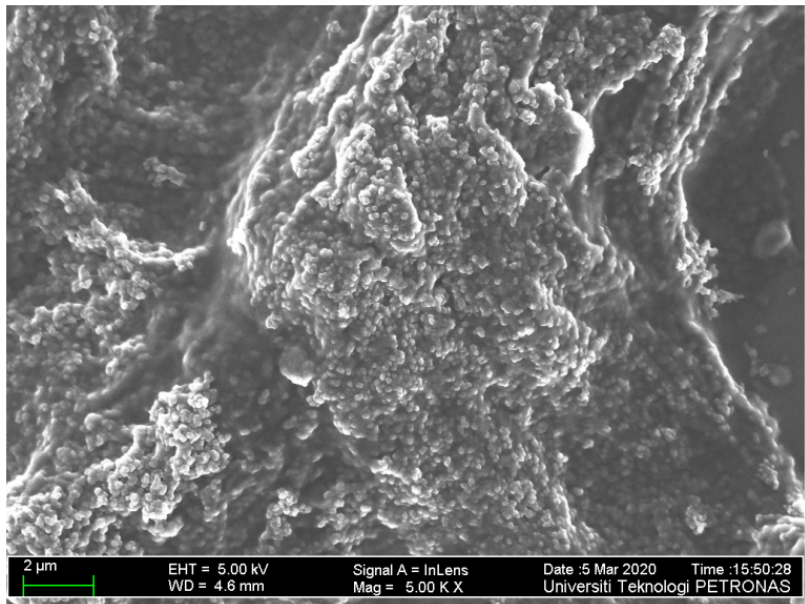
Figure 3. FESEM image showing the morphology of ternary thin film deposited on the gold layer.